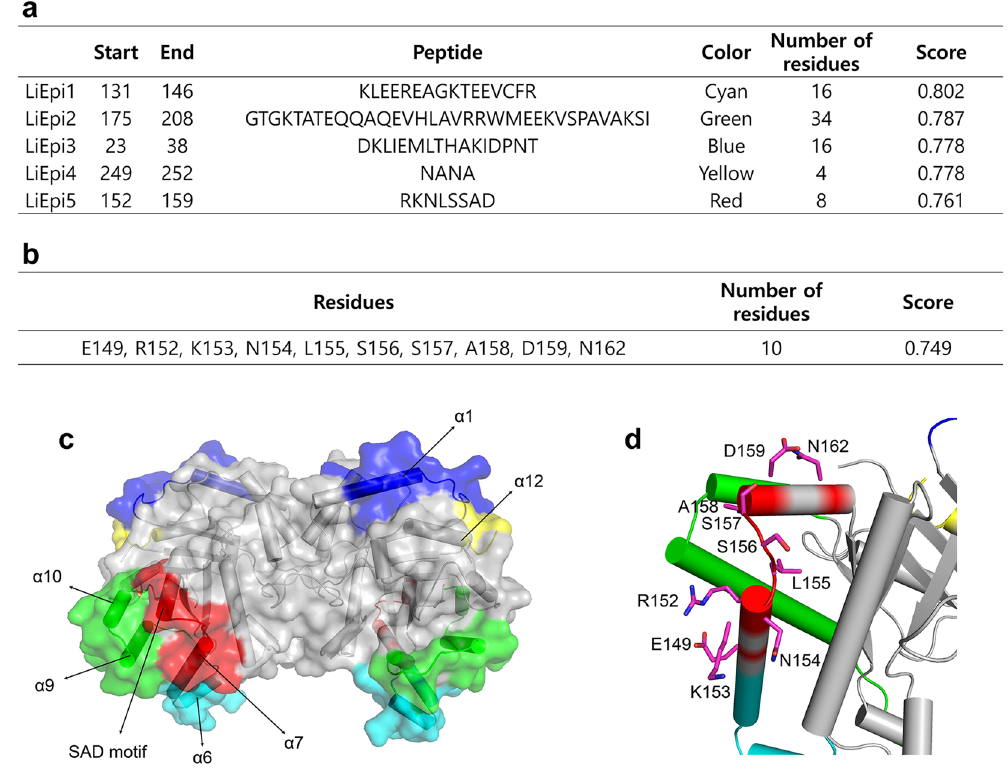
Figure 5. Structure-based epitope prediction of OvTIM. ( a , b ) Predicted linear epitope ( a ) and discontinuous epitope ( b ) from the ElliPro results. For precise results, the dimer structure of OvTIM was used, and possible epitopes with a score over 0.7 are listed. ( c ) The results of the predicted linear epitope in ( a ) are designated on the surface model of OvTIM. ( d ) The residues predicted to form discontinuous epitope are represented as a stick